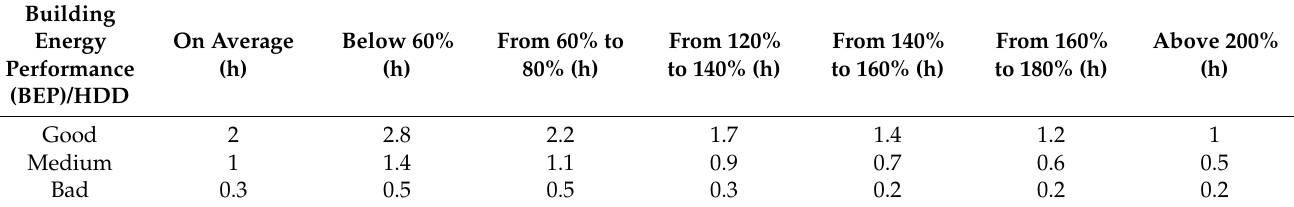
Table 3. DR event duration rationale—heating.